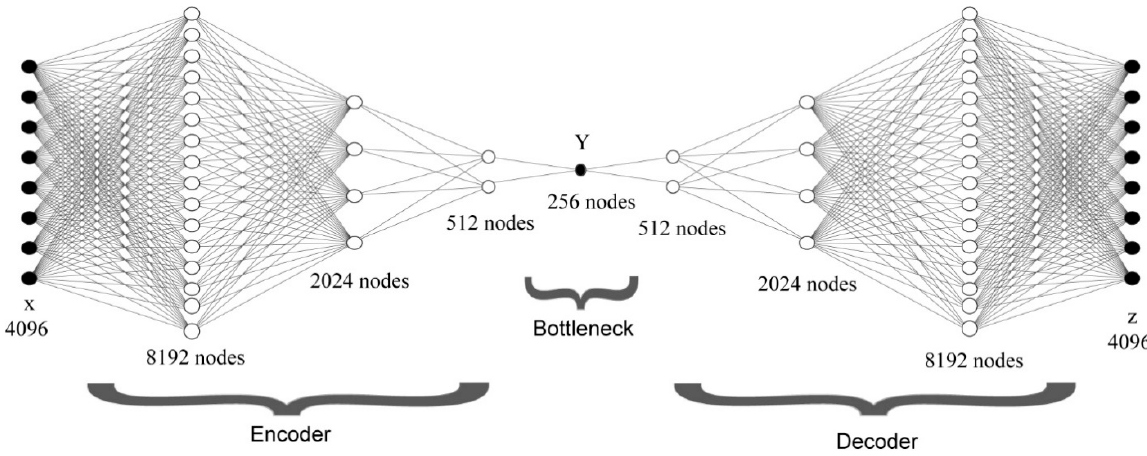
Figure 4. Optimized architecture of deep-stacked auto-encoder. According to the input direction, the first hidden layer of the encoder is a network of 8192 neurons. Later, we reduced the dimensions to 256 neurons, i.e., 𝑌 , through two other hidden layers. In the decoder section, we reconstruct 𝑧 , ideally the same as the input 𝑥 , using the same number of neurons and layers in the opposite directions.